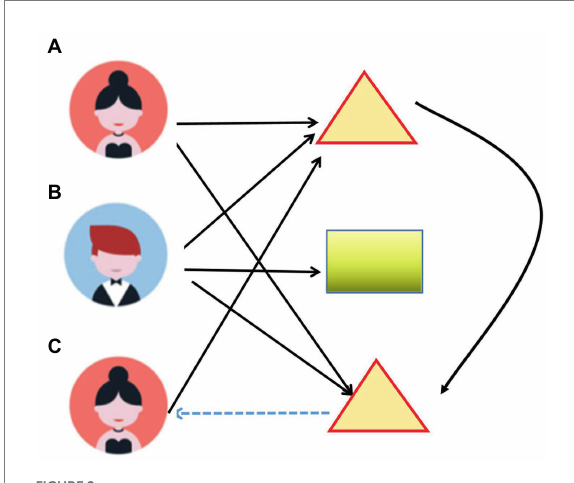
FIGURE 2 Application of CF algorithm in mental health transmission